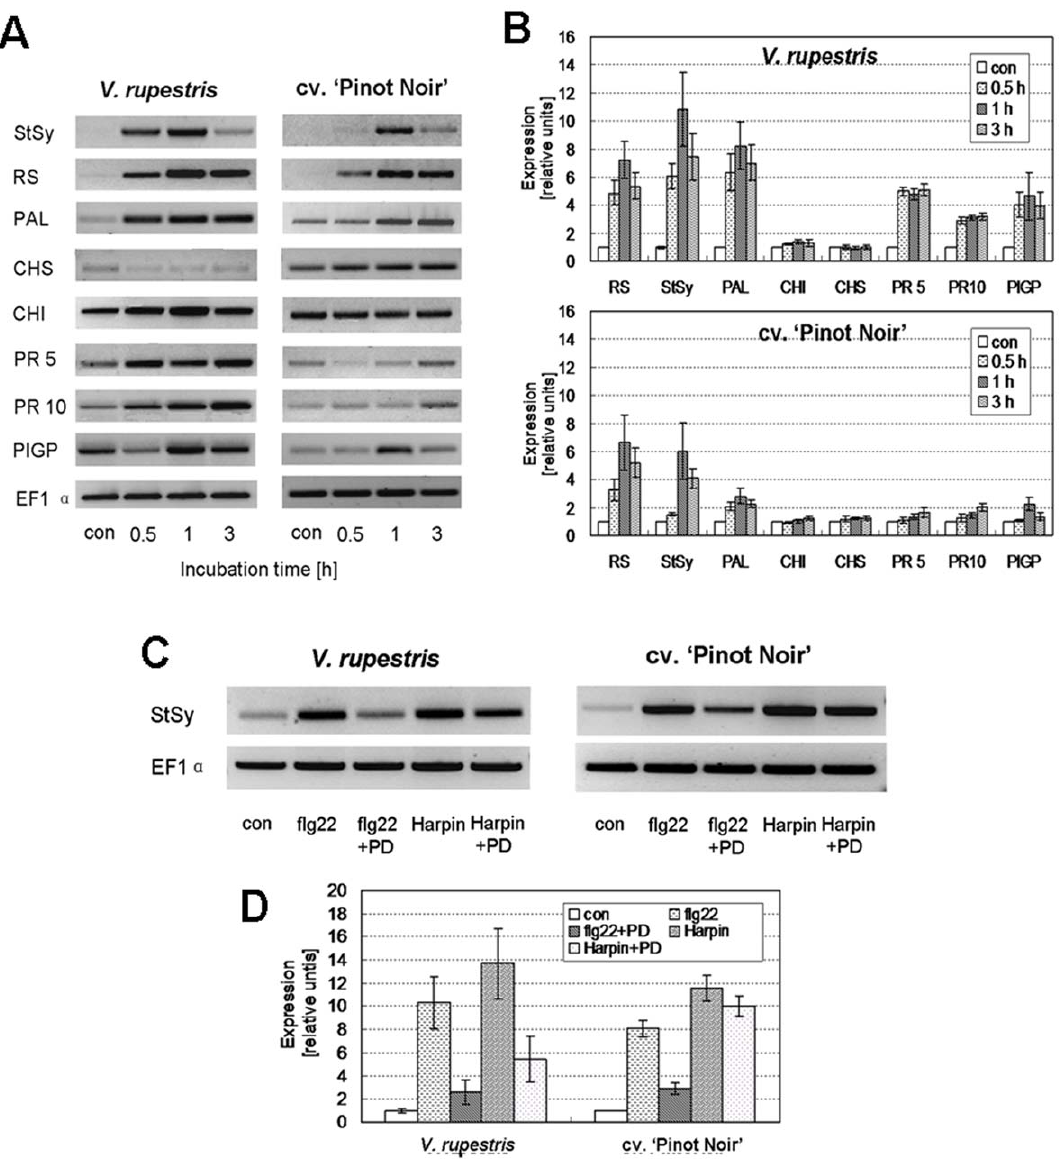
Figure 4. Expression of defence-related genes induced by flg22. A, B Representative gels showing transcript abundance followed by semi- quantitative RT-PCR after elicitation with 1 m M flg22 ( A ), and quantification relative to elongation factor 1 a ( B ) as reference. The data represent mean values from three independent experimental series; error bars show standard errors. Genes of interest encode proteins including PAL, phenylalanine ammonium lyase; CHS, chalcone synthase; StSy, stilbene synthase; RS, resveratrol synthase; and CHI, chalcone isomerase; pathogenesis-related proteins: PR10 ad PR5, and PGIP: polygalacturonase-inhibiting protein. C, D Influence of MAPK signalling on the abundance of StSy transcripts. Cells were challenged by 1 m M flg22, by 9 m g . ml 2 1 Harpin (both in the solvent DMSO) alone or in combination with the MAPK cascades inhibitor PD98059 (PD). A representative agarose gel is shown in C , the quantification relative to elongation factor 1 a from four independent experimental series in D , error bars represent standard